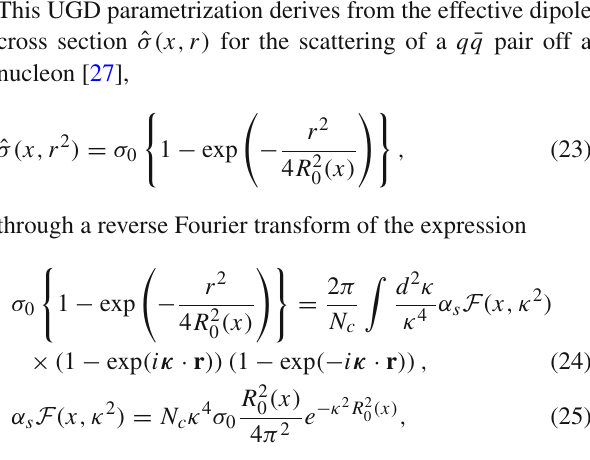
Fig. 4 Q 2 -dependence of the transversely polarized cross section, σ T , for all the considered UGD models, at W = 75 GeV together with the HERA data (left upper panel) and at W = 20 , 30 , 50 GeV for EIC (the